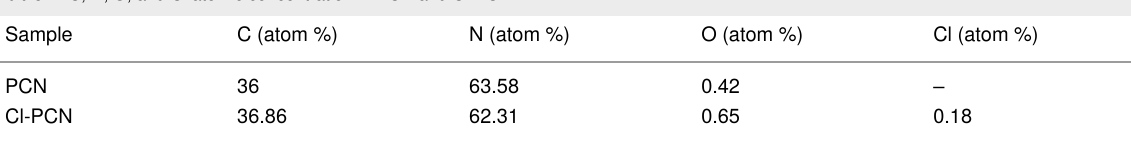
Table 1: C, N, O, and Cl atomic concentration in PCN and Cl-PCN.